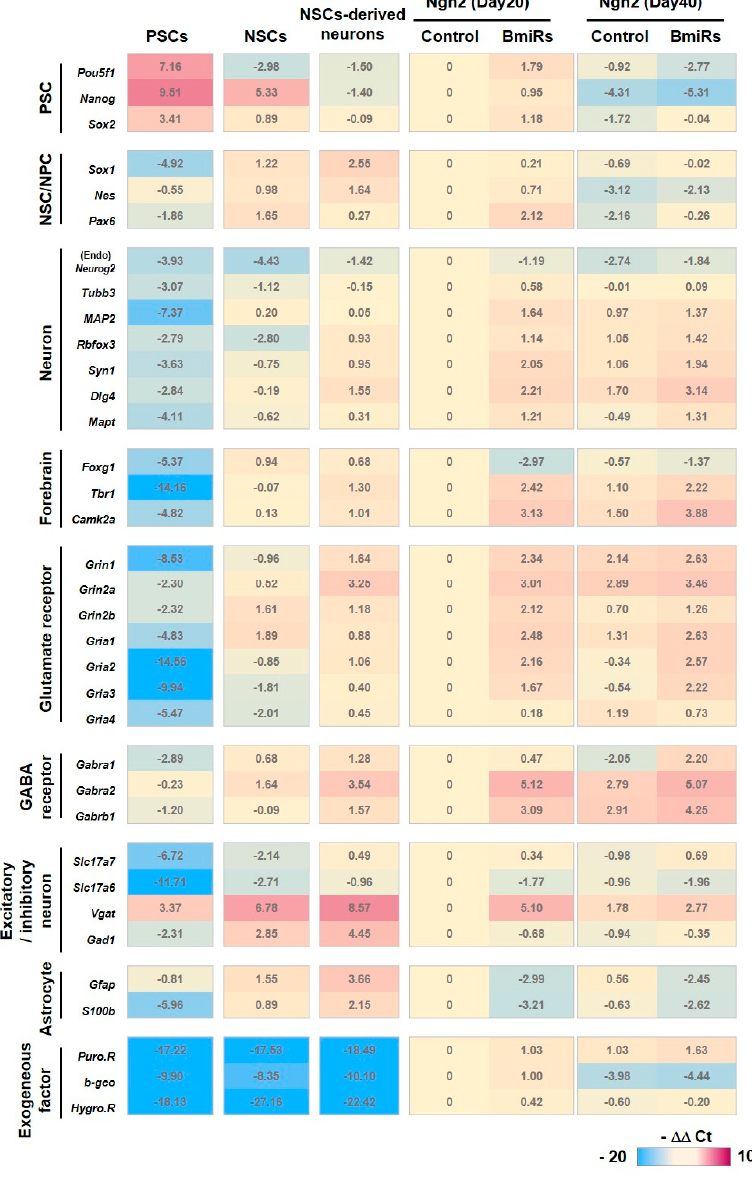
Figure 3. Gene expression profiling of the differentiated neurons. Using the KhES1, 201B7, 414C2, and 1210B2 lines, cells in each indicated differentiated state (PSCs, NSCs (day 20), NSCs-derived neurons (day 40) and Ngn2 -induced neurons with or without BmiRs expression (day 20 and 40)) were harvested and subjected to Real-time RT-PCR. Analyzed data were summarized asa heatmap and corresponds to the - ΔΔ Ct value. The numerical value in each cell is the averaged - ΔΔ Ct value in each target, which is standardized by the data of Ngn2 without BmiRs-induced neurons (Day 20).